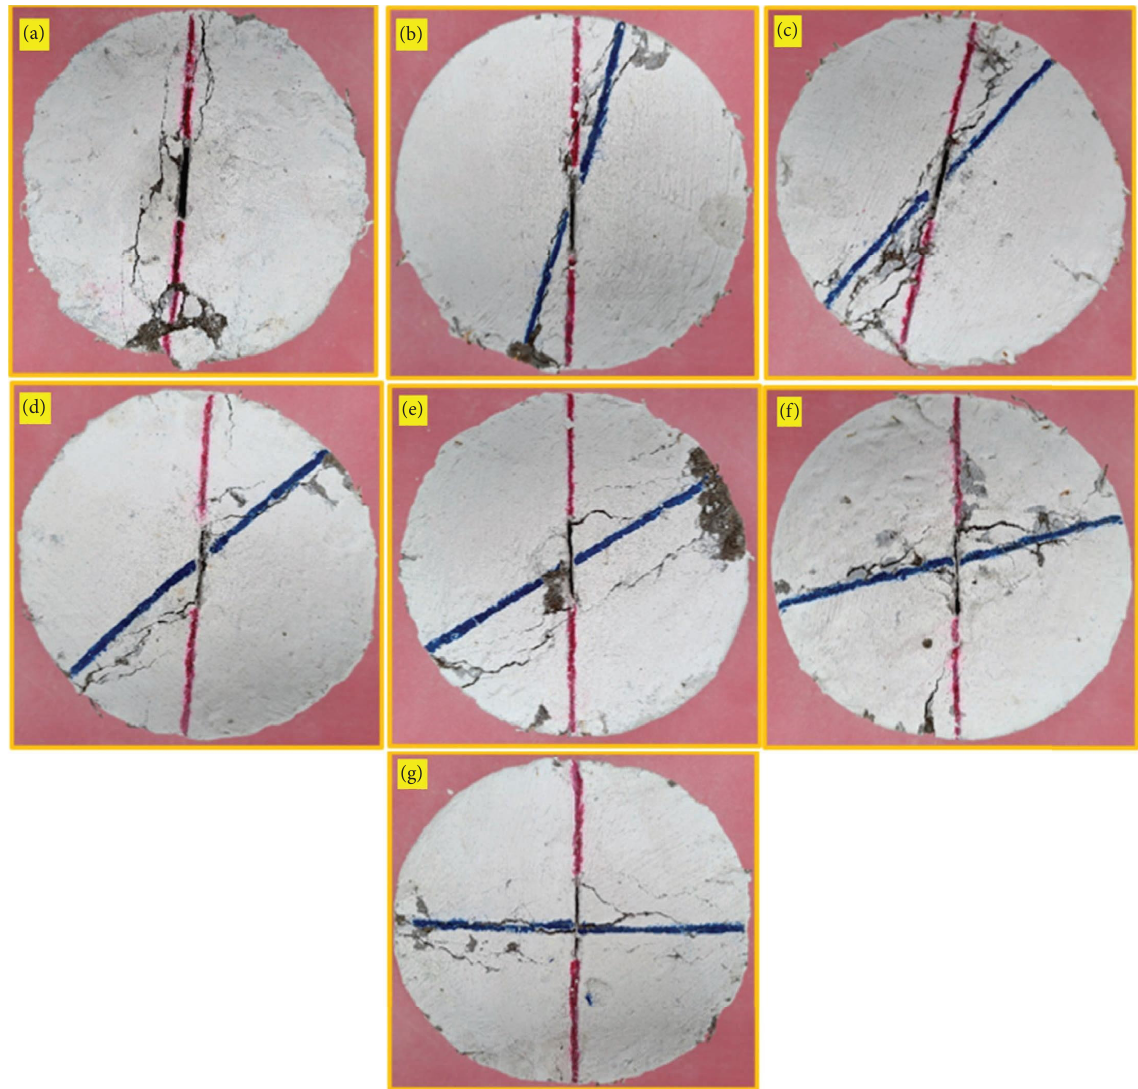
Figure 18: Fracture of long steel fbrous specimens at diferent loading angles: (a) 0 ° , (b) 15 ° , (c) 28.83 ° , (d) 45 ° , (e) 60 ° , (f) 75 ° , and (g) 90 °